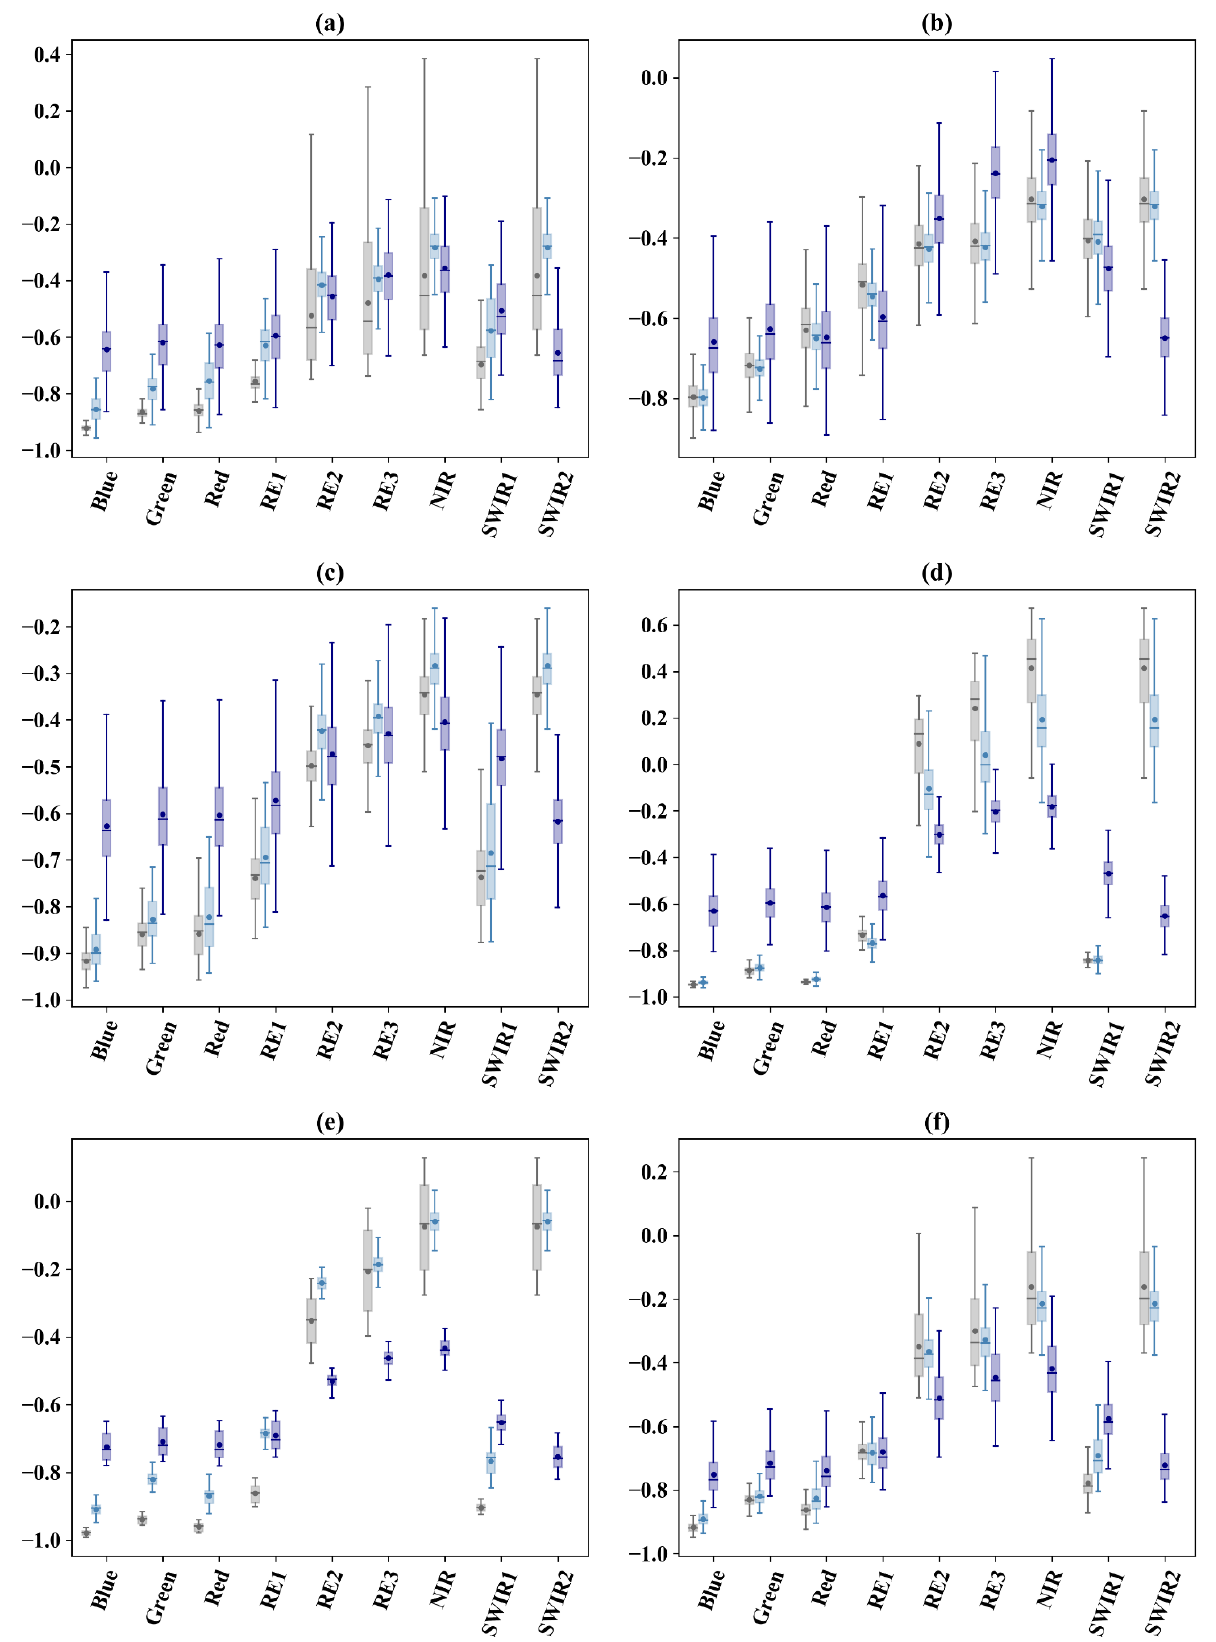
Figure 3. Spectral behaviour depicted using boxplots of the normalized pixel values for the real image (gray) and synthetic pixel values for cGAN (light blue) and WS (dark blue) images. Each chart corresponds to one land use class (a) maize; (b) uncultivated soil; (c) cerrado; (d) cotton; (e) eucalyptus; and (f) pasture. Inside the boxplots the line indicates the pixels median, while the dot represents the